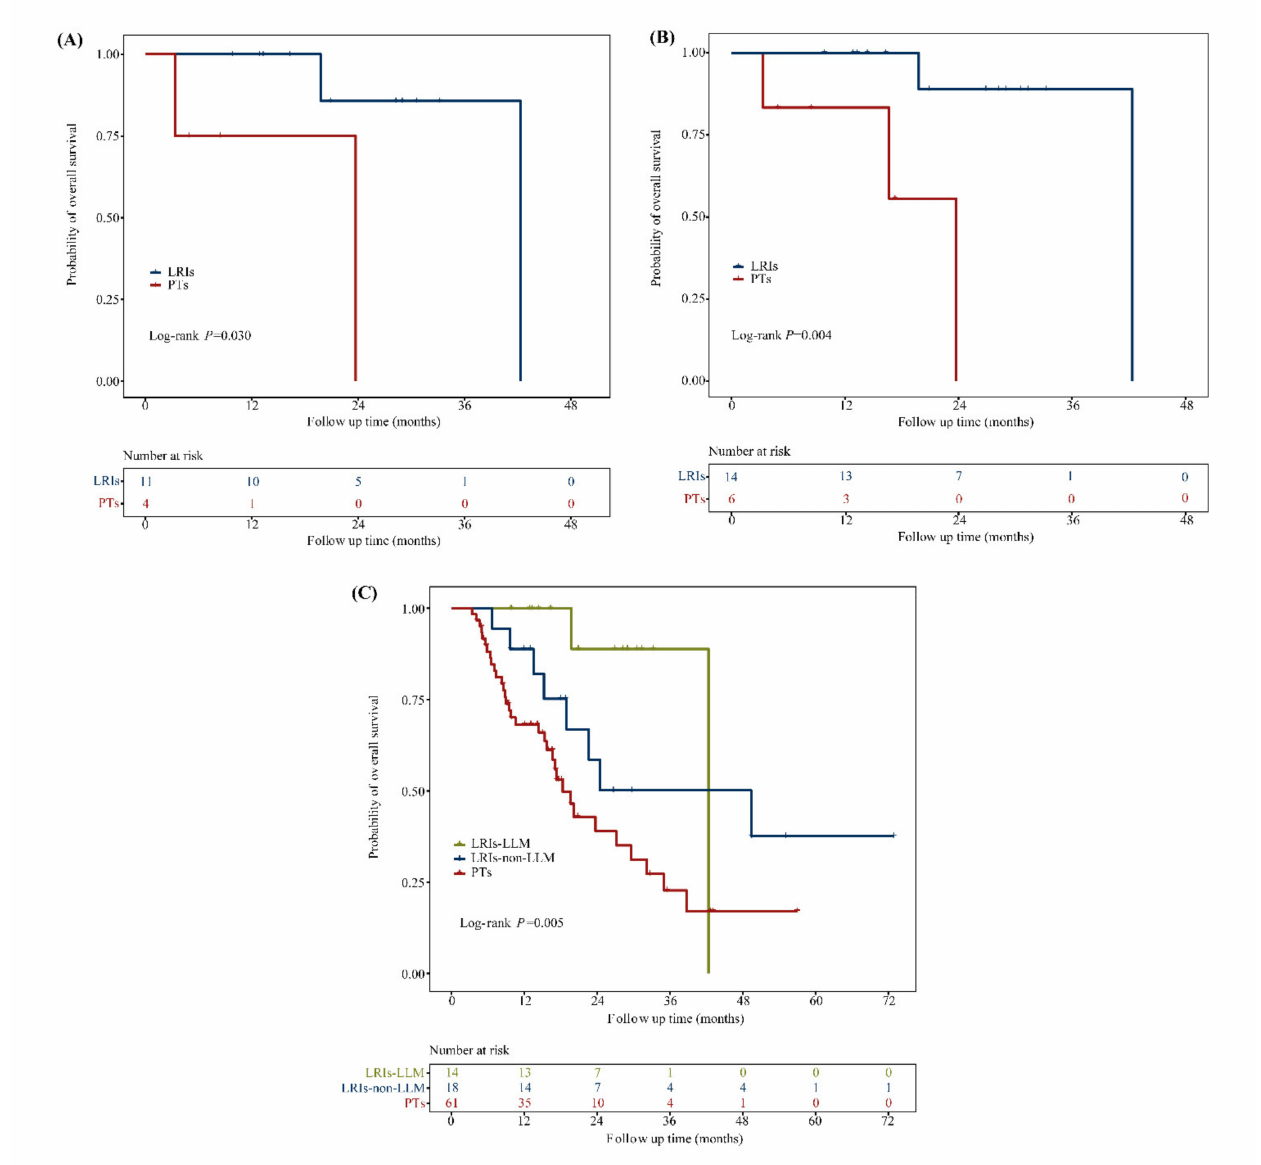
Figure 4. Kaplan–Meier analysis of OS in mCRC patients with the BRAF V600E mutation. ( A ) CRLM cohort, LRIs for patients with CRLM vs PTs for patients with CRLM, median OS: 42.4 vs 23.7 months, HR: 0.11, 95% CI: 0.01–1.22, p = 0.030. ( B ) LLM cohort, HR: 0.07, 95% CI: 0.01–0.69, p = 0.004. ( C ) Three subgroups of LLM from LRIs, non-LLM from LRIs and PTs, respectively. LRIs for patients with LLM vs. PTs, HR: 0.16, 95% CI: 0.04–0.68, p = 0.006. LRIs for patients with non-LLM vs. PTs, HR: 0.47, 95% CI: 0.21–1.05, p = 0.074. Abbreviations: LRIs, locoregional interventions; PTs, palliative treatments; LLM, liver-limited or lung-limited metastasis; LRIs-LLM, patients with LLM received LRIs; LRIs-non-LLM, patients who were not LLM received